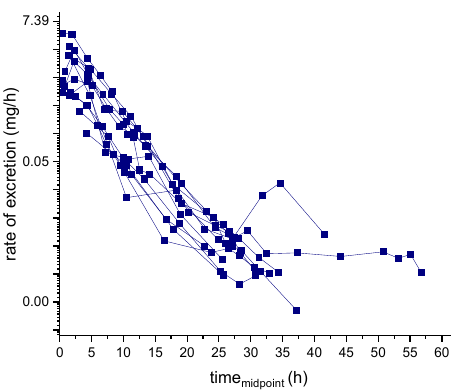
Figure 6. Ecdysterone ln-transformed excretion rate.